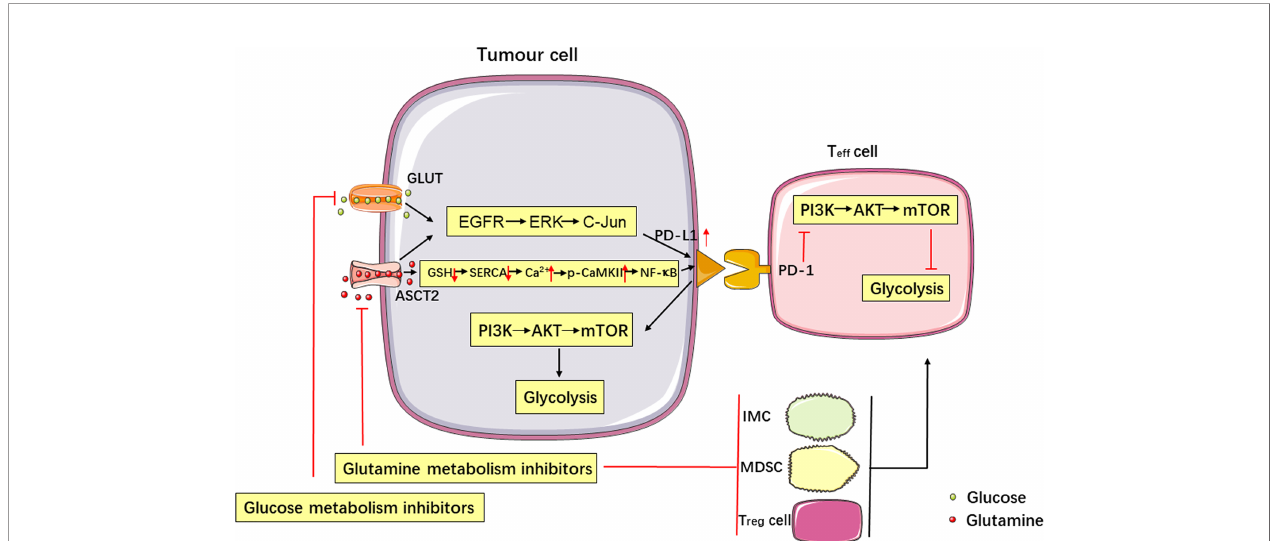
FIGURE 1 | Metabolism affects tumor immune escape, and the PD-1/PD-L1 immune checkpoint regulates metabolic pathways. Glucose and glutamine metabolism upregulate the expression of PD-L1 in tumor cells via the EGFR/ERK/C-Jun pathway. Inhibition of glutamine use in tumor cells increases PD-L1 expression by reducing the levels of GSH, inhibiting the SERCA activation, and increasing cytosolic Ca2+ levels and CaMKII phosphorylation, which further activates the downstream NF- k B signalling pathway. Targeting glutamine metabolism can inhibit the production of immune cells negatively affecting the immune response (IMCs, MDSCs and T reg cells) and upregulate the function of T eff cells, thereby enhancing the antitumor immune response. Activation of the PD-L1/PD-1 signalling pathway promotes aerobic glycolysis (i.e., the Warburg effect) in tumor cells, inhibits glucose metabolism in T eff cells by stimulating the PI3K-AKT-mTOR signalling pathway, and produces synergistic inhibition of the antitumor